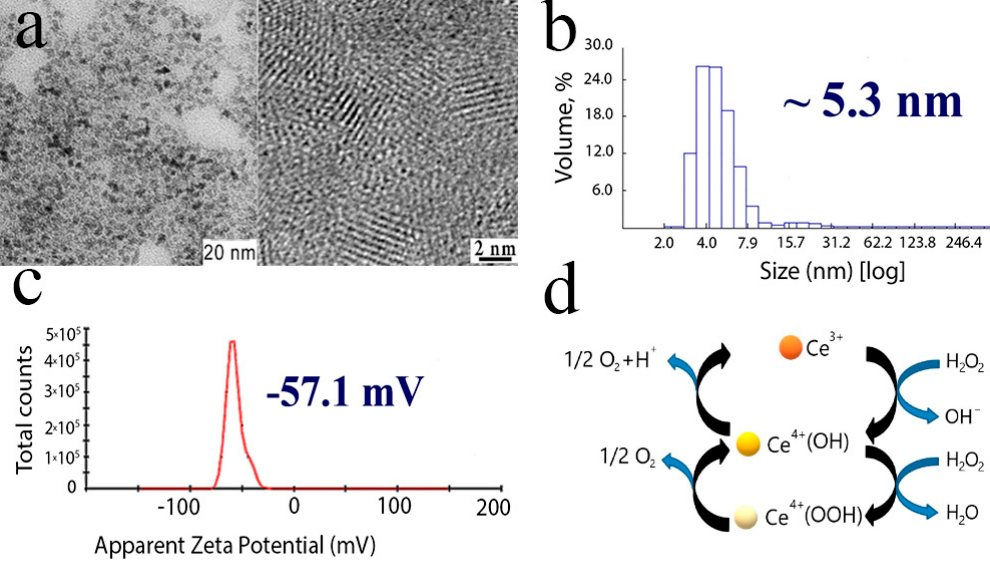
Figure 1. Cerium oxide nanoparticles: TEM and high-resolution TEM images ( a ), particle size distribution ( b ), zeta-potential ( c ), schematic representation of catalase-like activity of citrate-stabilised CeO 2 nanoparticles ( d ).